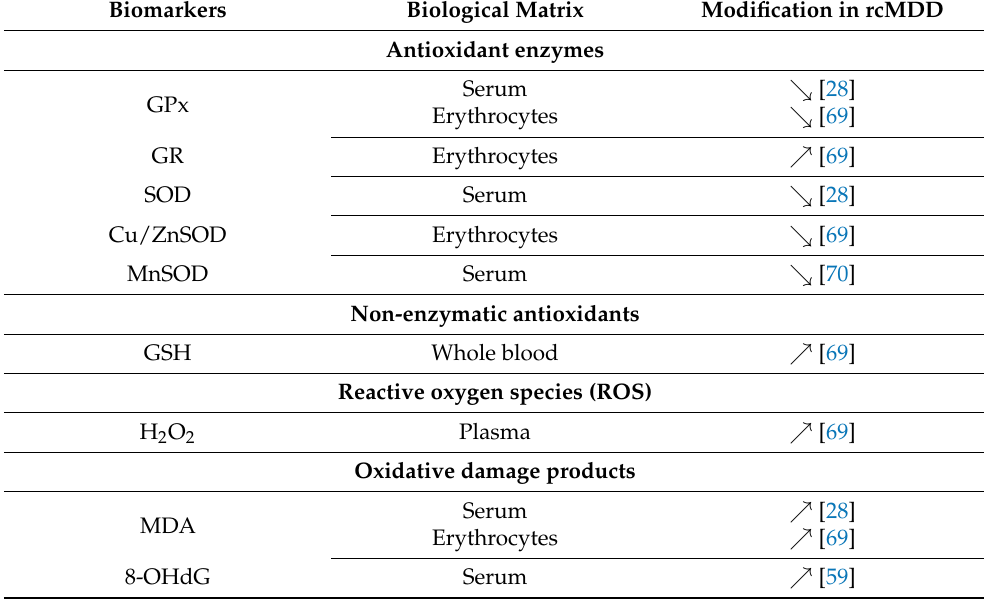
Table 4. Peripheral biomarkers of oxidative stress in recurrent MDD patients compared to healthy controls. rcMDD: Recurrent major depressive disorder—GPx: Glutathion Peroxydase—GR: Glu- tathion Reductase—SOD: Superoxide dismutase (information about isoform was not provided)— Cu/ZnSOD: Type 1 isoform of SOD—MnSOD: Type 2 isoform of SOD—GSH: Reduced form of glutathione—H 2 O 2 : Hydrogen peroxide—MDA: Malondialdehyde—8-OHdG: 8-hydroxy-2 (cid:48)